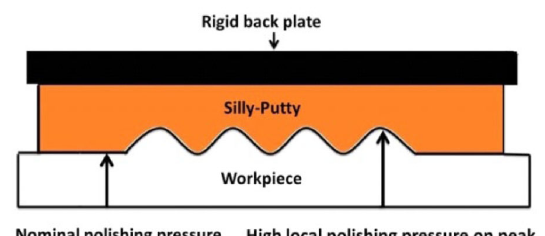
Fig. 1 RC-lap polishing pressure distribution induced by sinusoidal error.